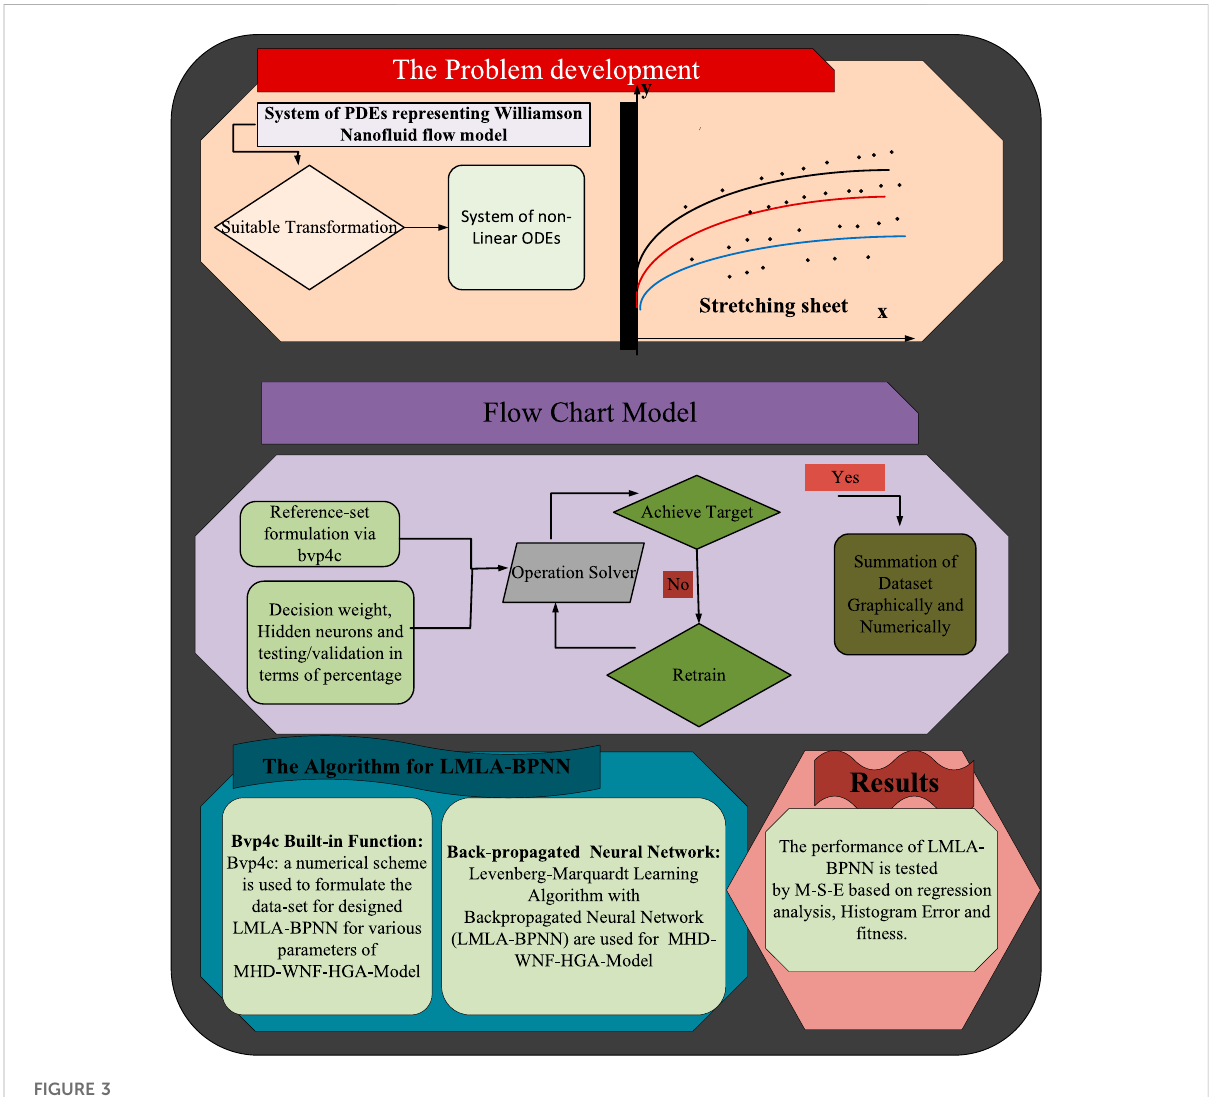
FIGURE 3 Flow architecture of the MHD-WNF-HGA